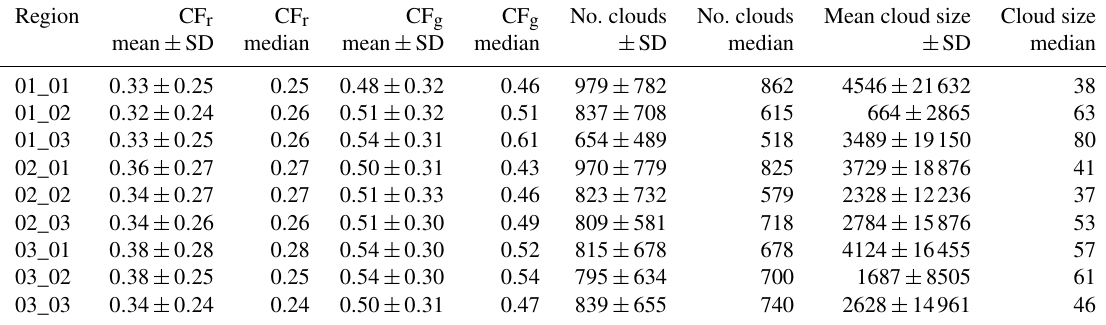
Table A1. Averaged cloud metrics calculated from the VIIRS data for the study period. Cloud size is in units of VIIRS pixels.